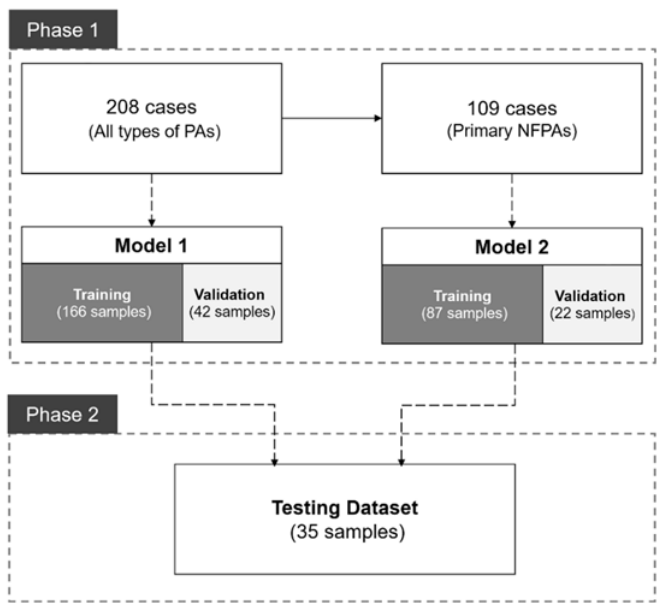
Figure 2. Schematic of the study design.